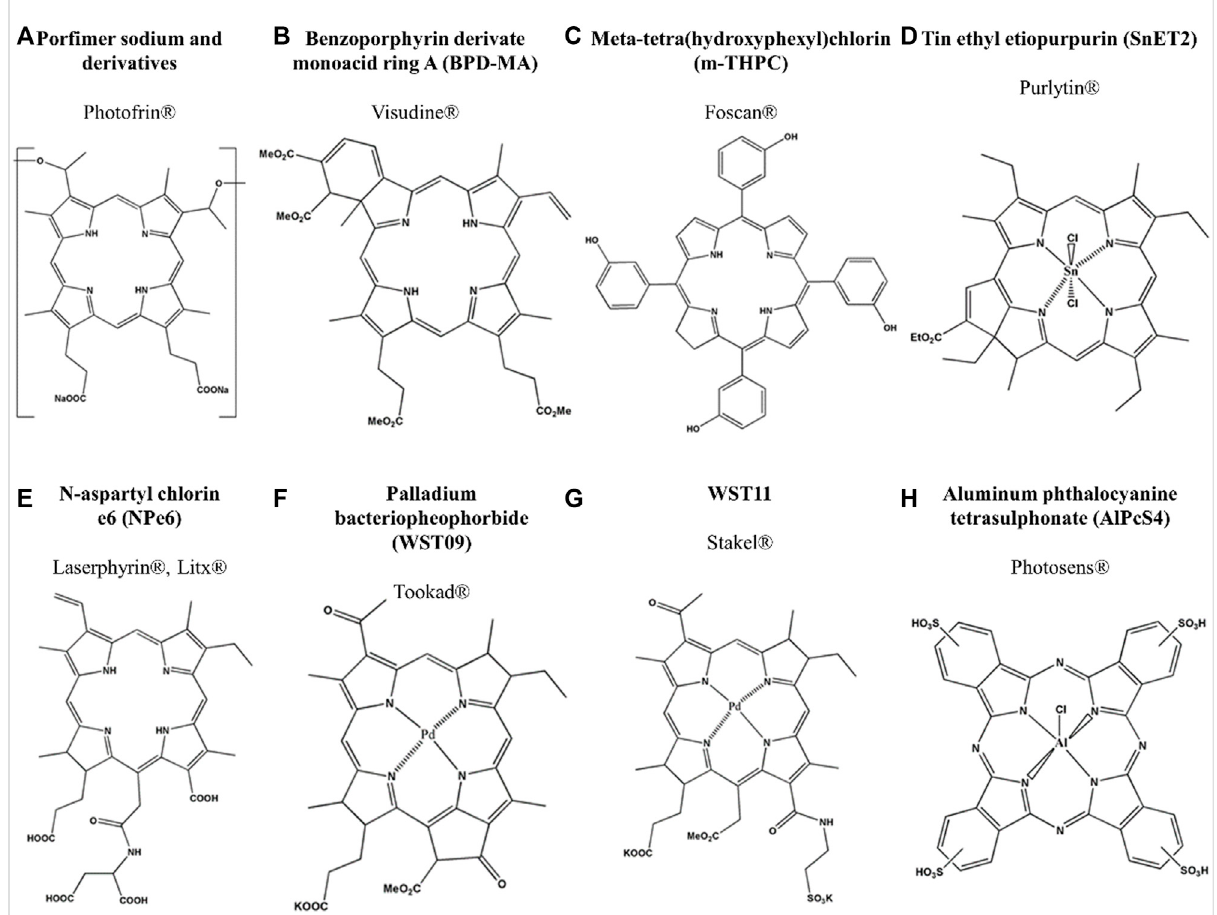
FIGURE 4 Structure of approved PS for PDT by regulatory agencies. (A) Photofrin, (B) Visudine, (C) Foscan, (D) Purlytin, (E) Laserphyrin, (F) Tookad, (G) Stakel and (H)